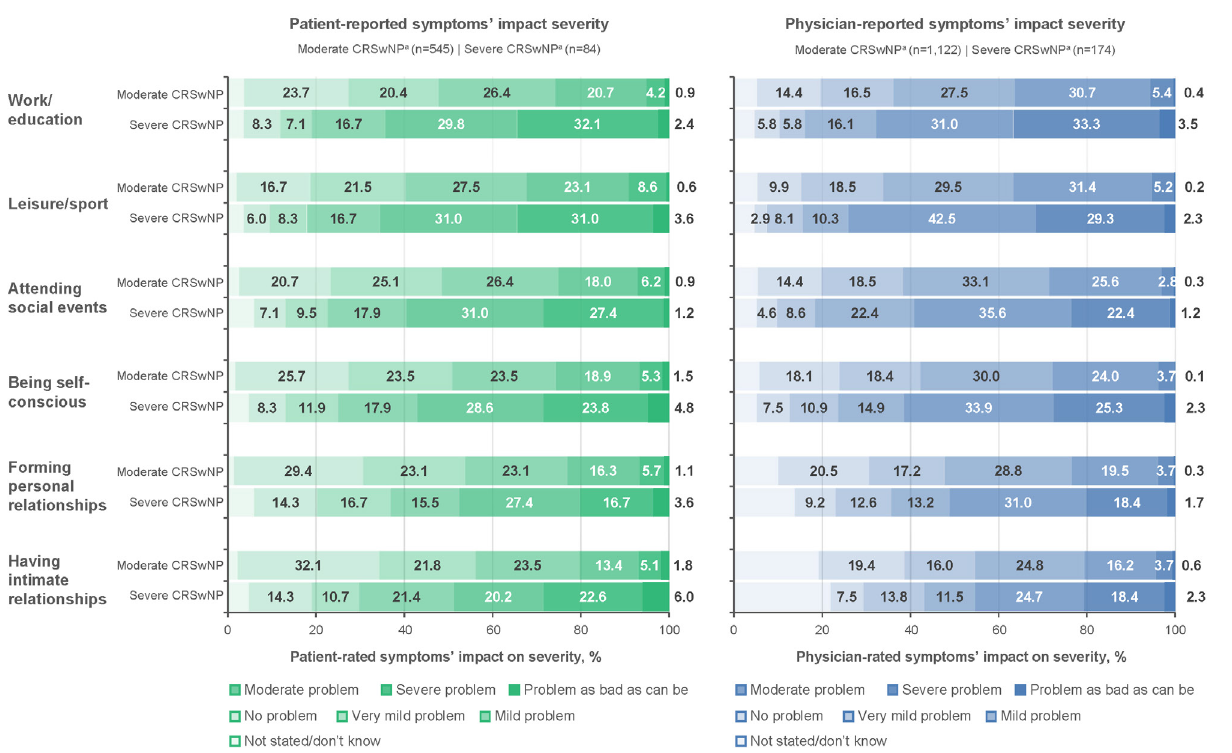
Supplemental Figure 3. Extent of CRSwNP symptoms’ impact on daily activities and relationships by categories of CRSwNP severity (consecutive sam-